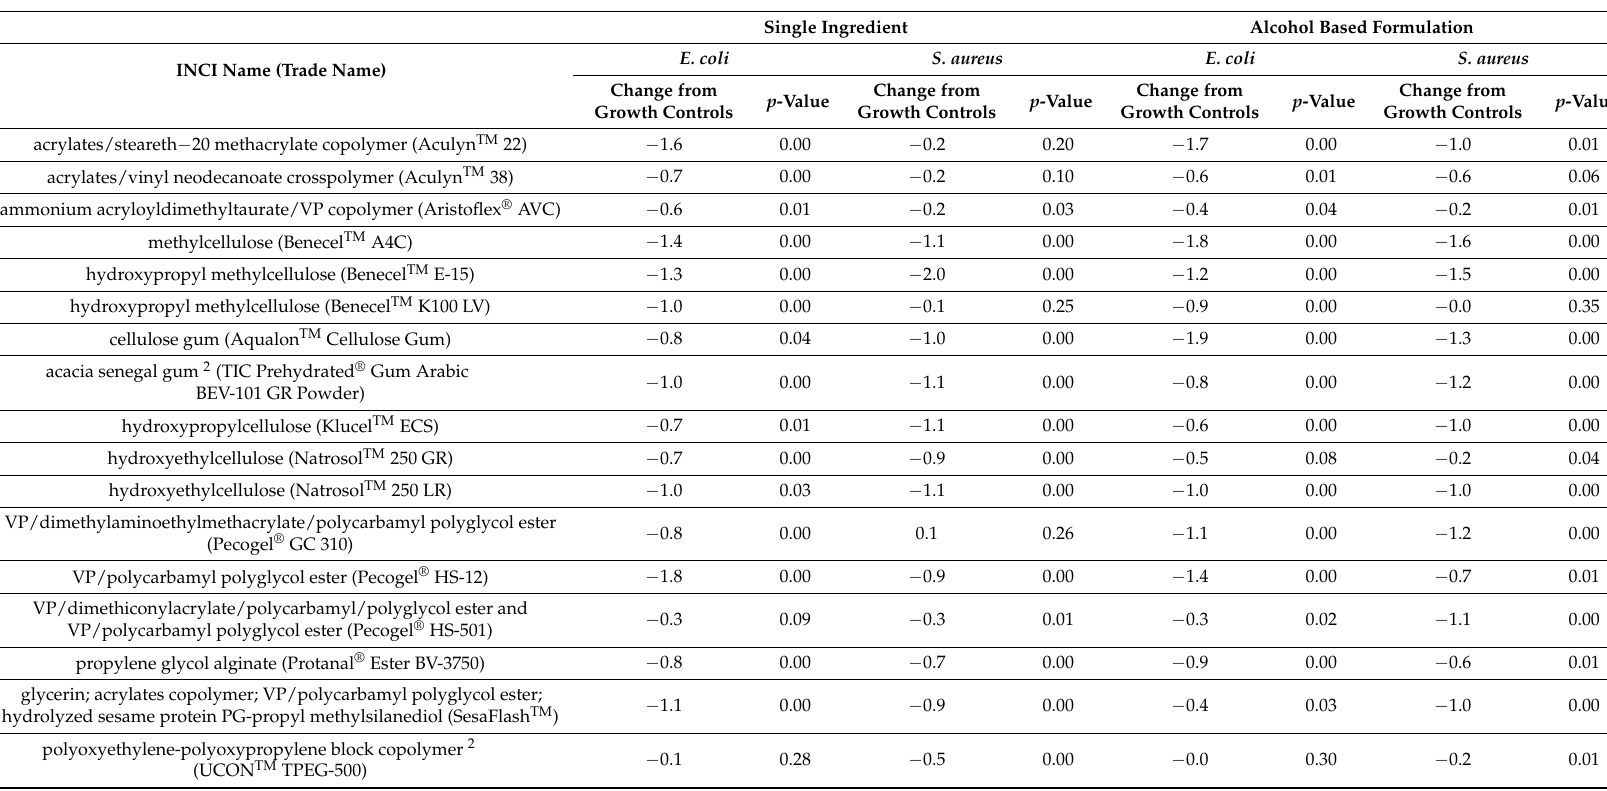
Table 1. Difference in viable counts (Log CFU/mL) of attached bacteria after exposure to personal care ingredients and formulations on pegs ( n = 4) compared to untreated pegs 1